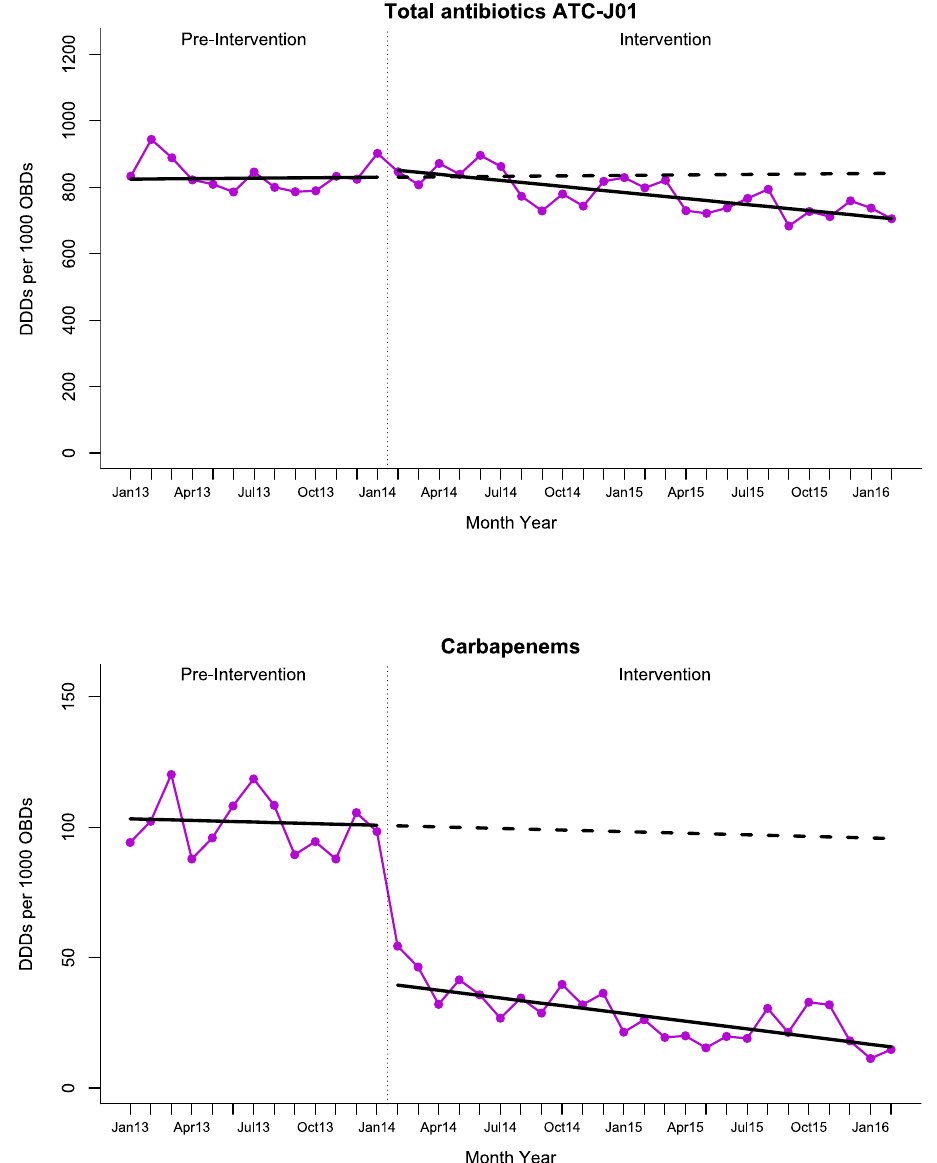
Figure 1. Interrupted time series analysis of the trends in ATC group J01 (antibacterials for systemic use) and carbapenem (meropenem/imipenem) consumption observed before and after the implementation of the antimicrobial stewardship program. Solid purple line: antibiotic consumption time series. Solid black lines: observed trend during the pre-intervention and intervention periods. Dashed black line: counterfactual (expected) trend after the intervention according to the pre-intervention values. DDDs: defined daily doses; OBDs: occupied bed days.